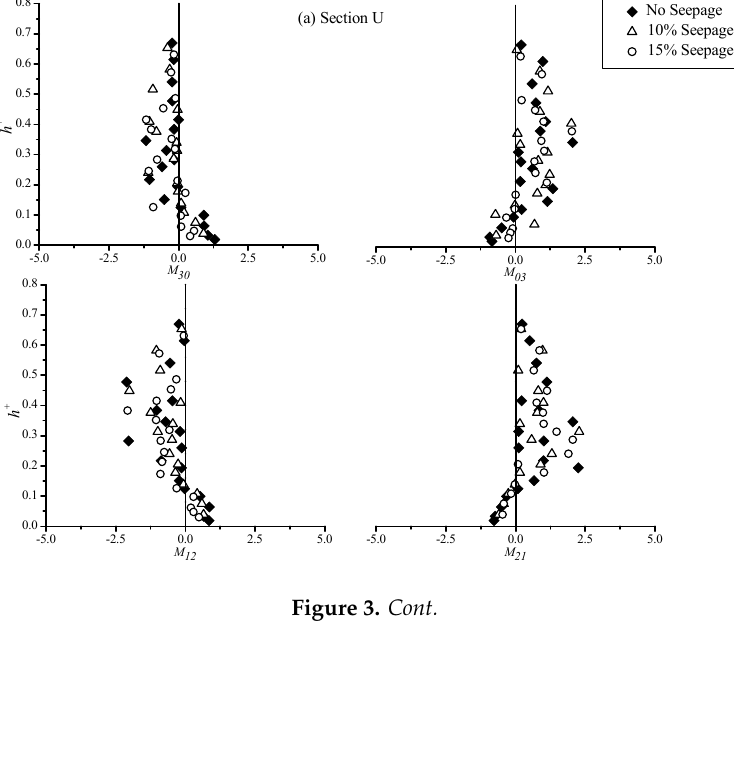
Figure 2. Non-dimensional distributions of turbulence intensities.